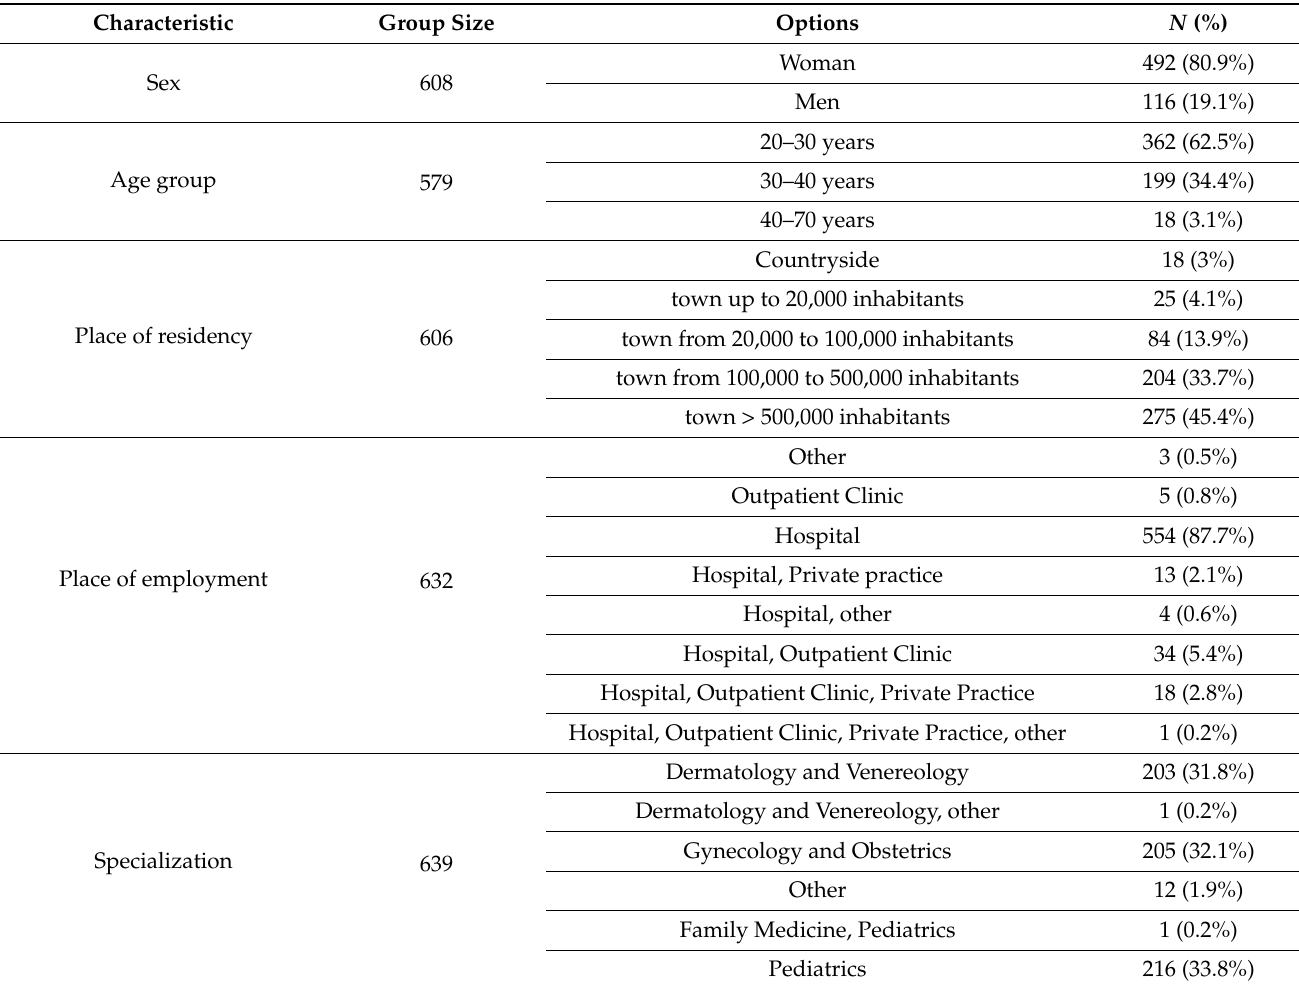
Table 1. Characteristic of the